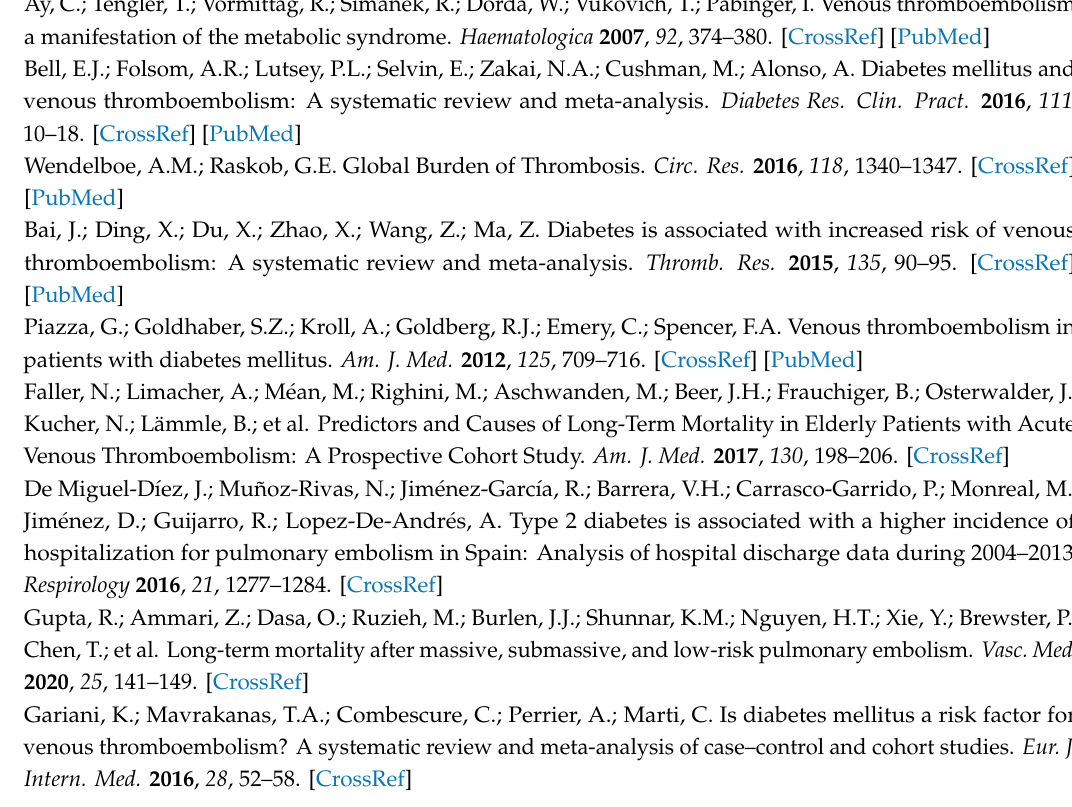
Table S1: ICD-10 codes for the clinical diagnosis and procedures used in this investigation. Table S2: In-hospital mortality according to specific comorbid conditions and procedures variables among men and women with and without type 2 diabetes (T2DM) hospitalized with pulmonary embolism in Spain (2016–2018). Table S3. Prevalence of thrombolytic therapy and inferior vena cava (IVC) filter placement among patients hospitalized with or without massive pulmonary embolism (PE) according to sex and type 2 diabetes (T2DM) status in Spain (2016–2018). Table S4. Distribution and in-hospital mortality (IHM) of atrial fibrillation according to its presence at admission among patients hospitalized with PE and with and without